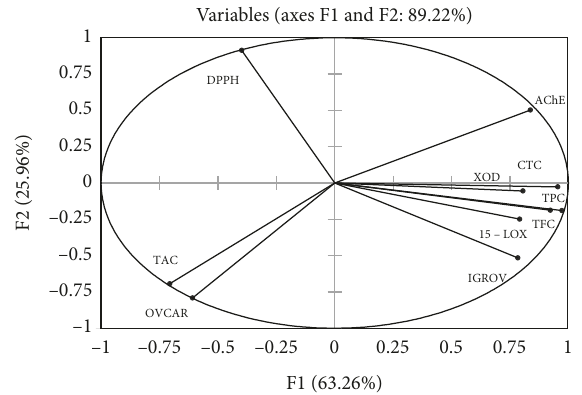
Figure 3: Principal component analysis “loading plot” of anti- oxidant properties (TPC: total phenolic content; TFC: total fla- vonoids content; TAC: total anthocyanins content; CTC: total condensed tannin content; DPPH: antioxidant activity) and bio- logical activities (AChE: antiacetylcholinesterase activity; 15-LOX: anti-15-lipoxygenase activity; IGROV and OVCAR, and cytotoxic activity) of M. mabokeensis Aubr´ev bark